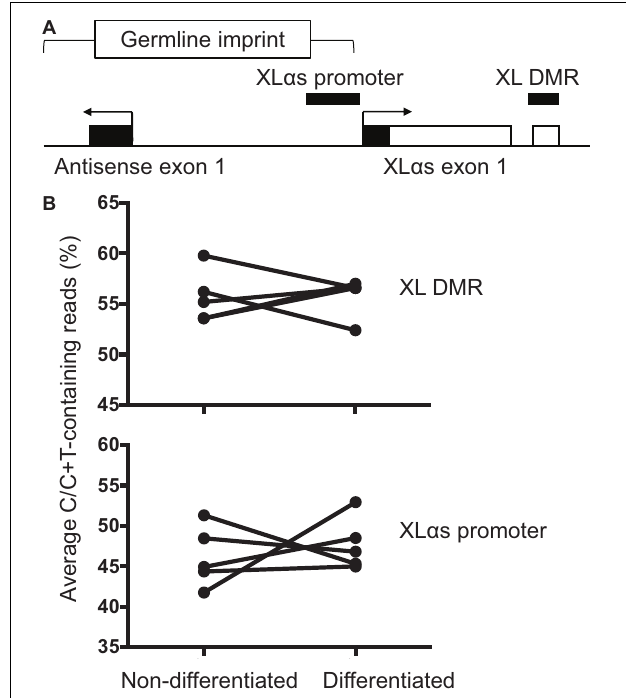
FIGURE 5 | Methylation of XL α s promoter and DMR in mouse BMSCs. (A) The genomic region comprising XL α s exon 1 and the promoter, including exon 1 of the GNAS antisense (also known as Nespas). The analyzed regions are indicated by horizontal bars. The five CpGs analyzed at XL DMR span chr2:174300870-174300902 (mm 10) and the 30 CpGs analyzed at XL α s promoter span chr2:174297234-174297623 (mm 10). Exons (open: coding, closed: non-coding) and introns are depicted by boxes and connecting lines, respectively. The direction of transcription is indicated by arrows. The female germline imprint previously identified in this region is indicated. (B) Average methylation across the analyzed region in individual non-differentiated and osteogenically differentiated mouse BMSC samples. The differences are not statistically significant; p = 0.92 for the XL α s DMR and p = 0.62 for the XL α s promoter (paired t -test,